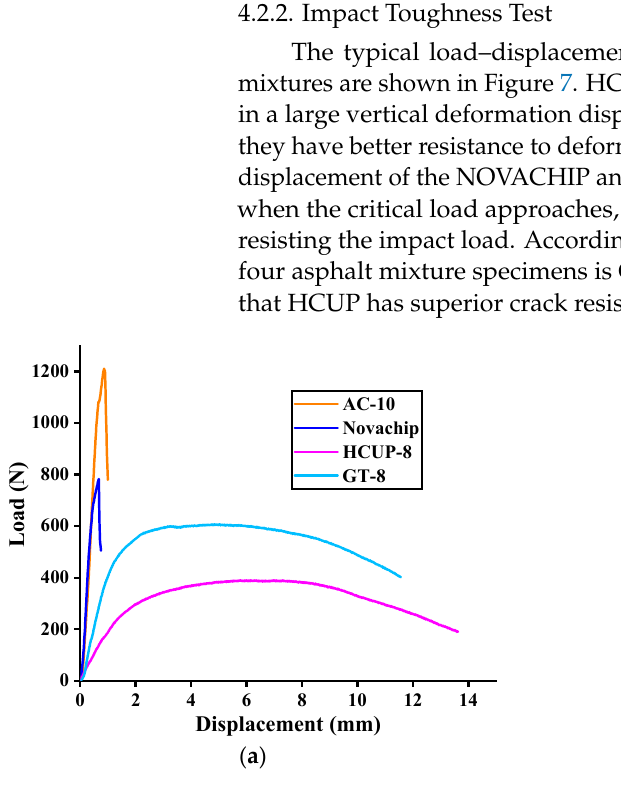
pact toughness curve.